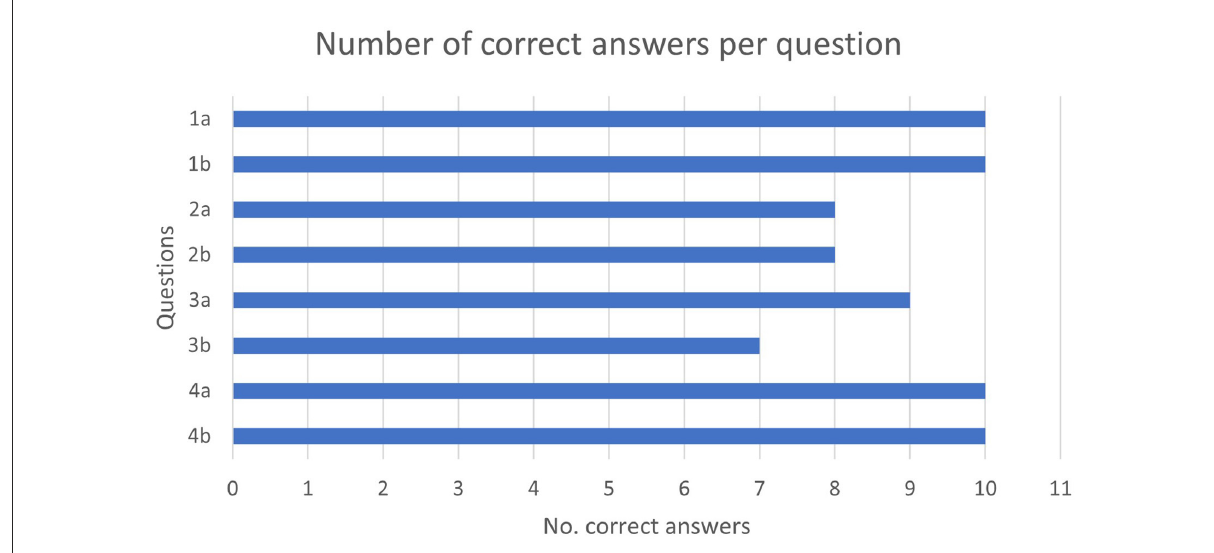
FIGURE3 Number of correct answers per